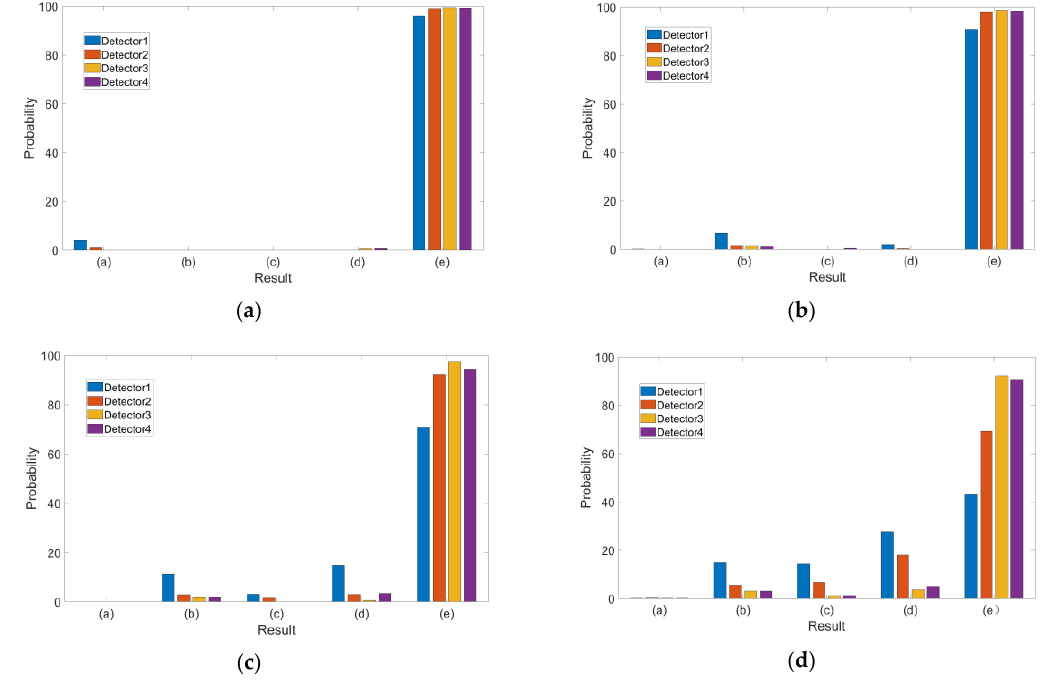
Figure 12. Identification result of four detectors in Case 3: ( a ) one, ( b ) two, ( c ) three and ( d ) four outliers.